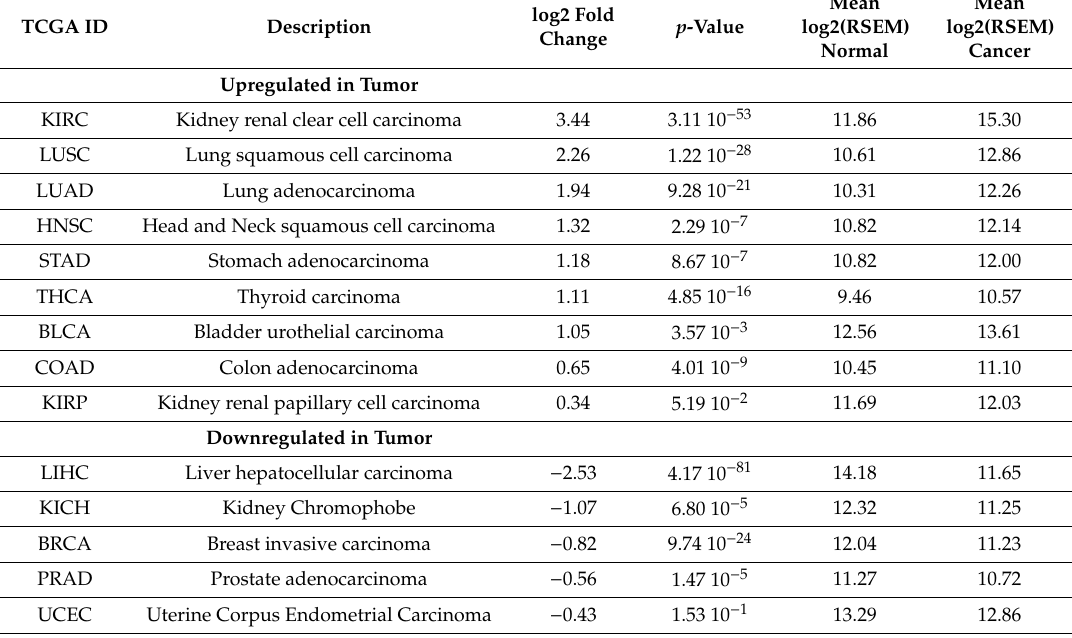
Figure 3. Cancer vs. normal IGFBP-3 log2 RSEM gene expression boxplots (all cancer). Description of abbreviations presented in Table 1. Table 1. Differential expression of IGFBP-3. “Mean log2(RSEM)”—average gene expression in normal and cancer tissues, respectively. t -test p -values are shown.